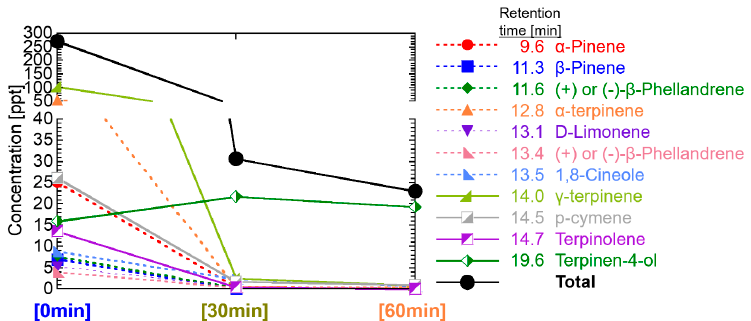
Figure 8. Temporal change of VOCs in the room air diffused by Tea tree oil.